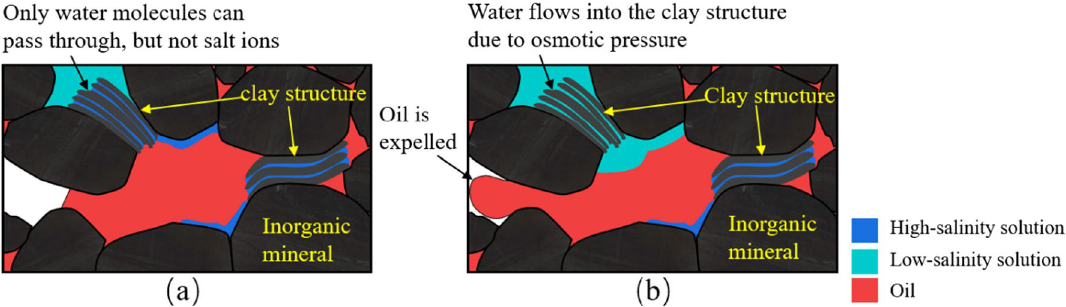
Fig. 12 Schematic diagram of osmosis mechanism in shale containing oil–water two-phase: a Pore space containing oil–water two-phase; b Water displaces the oil out of the